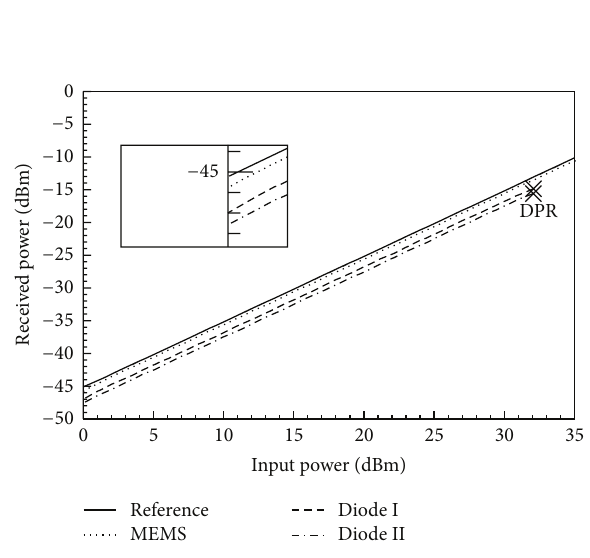
Figure 19: Comparison of the received power for the reconfigurable monopole antenna with RF switches in the far-field condition.